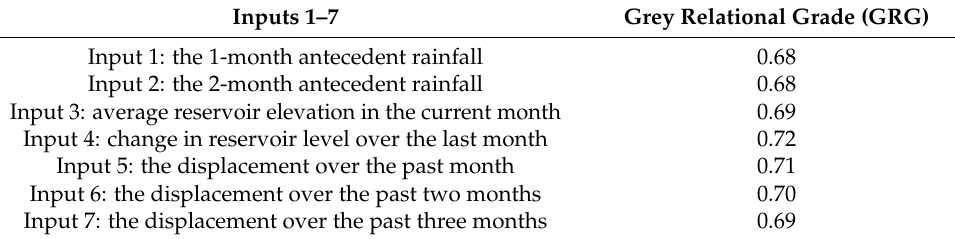
Table 1. Candidate factors for the periodic displacement of Baijiabao landslide.